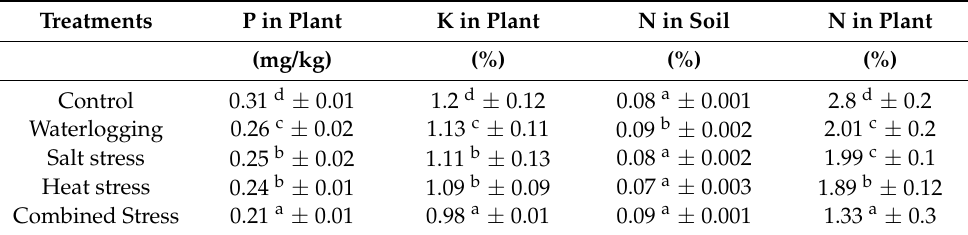
Table 4. Phosphorous, potassium, and nitrogen accumulation in wheat plants grown under different abiotic stresses. Treatments P in Plant K in Plant N in Soil N in